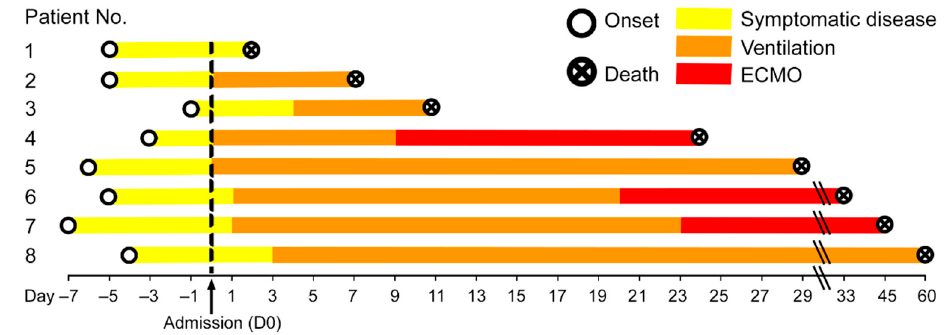
Figure 1. Disease duration of the patient cohort in our study. The disease course of each of the eight COVID-19 patients is shown from disease onset until death. Hospital admission was denoted as day 0, the therapies are color-coded. Patient 1 had the shortest time between the beginning of symptomatic disease and death, i.e., six days, while patient 8 had the longest disease course till death with eight weeks of mechanical ventilation.